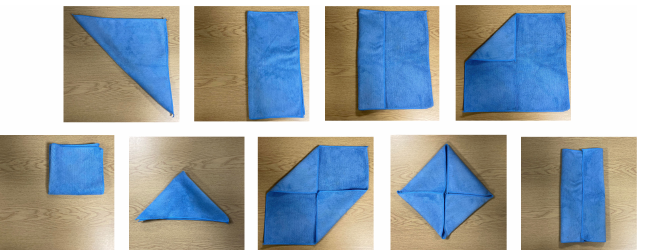
Figure 4. Different folding tasks on a square fabric, where the figure is modelled after Weng et al. (2022) [237]: The first row displays the goal images of single-step folding tasks including diagonal folding, rectangular folding, side folding, one-corner inward folding from left to right; the second shows the ones of multi-step folding, including cross folding, diagonal cross-folding, double-corner inward folding, all-corner inward folding and double